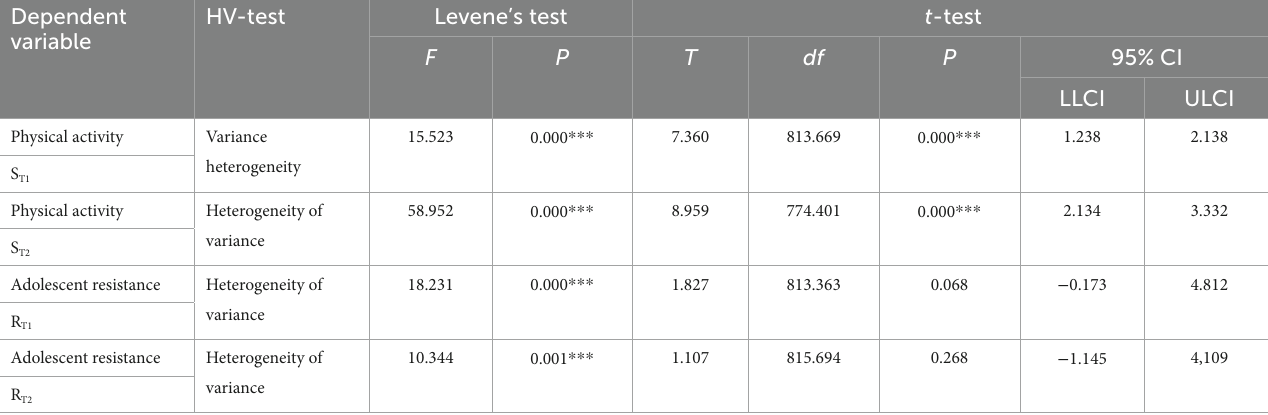
TABLE 5 T -test of the relationship between physical activity and adolescent resilience. Dependent